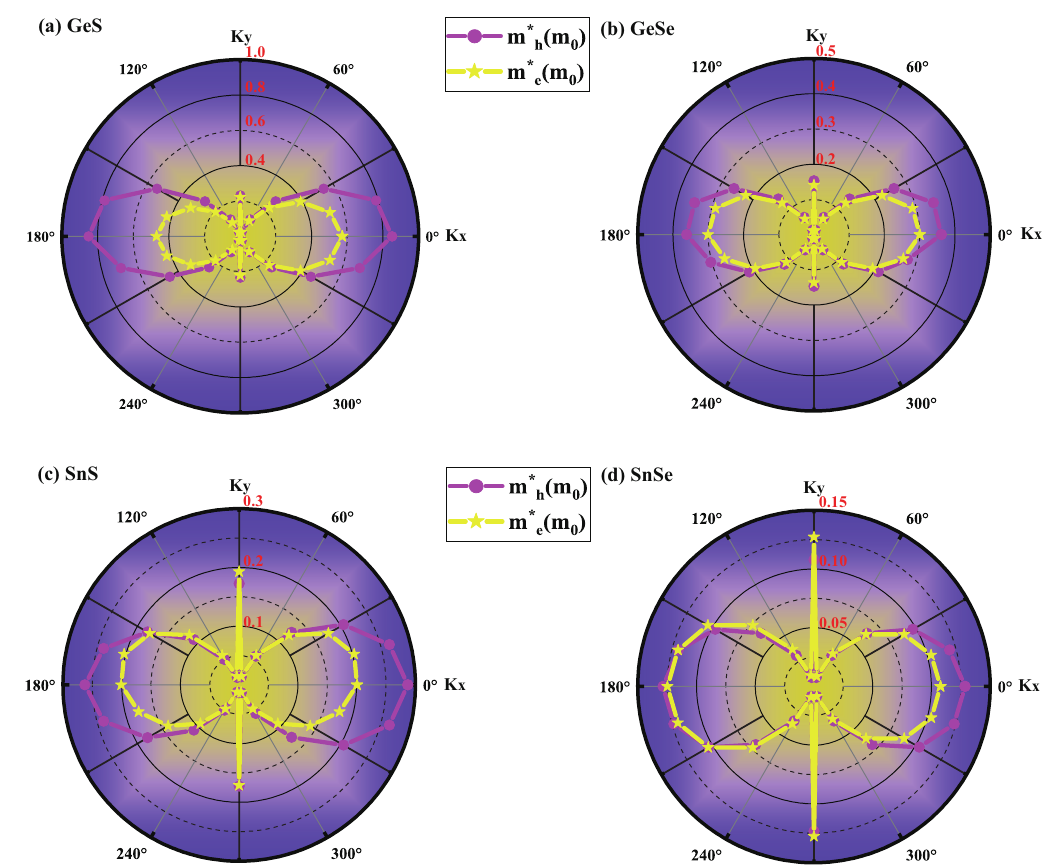
Figure 3. Angular dependence on the effective masses of holes and electrons of monolayer ( a ) GeS; ( b ) GeSe; ( c ) SnS and ( d ) SnSe. The purple and yellow lines indicate the effective mass curves of holes and electrons,